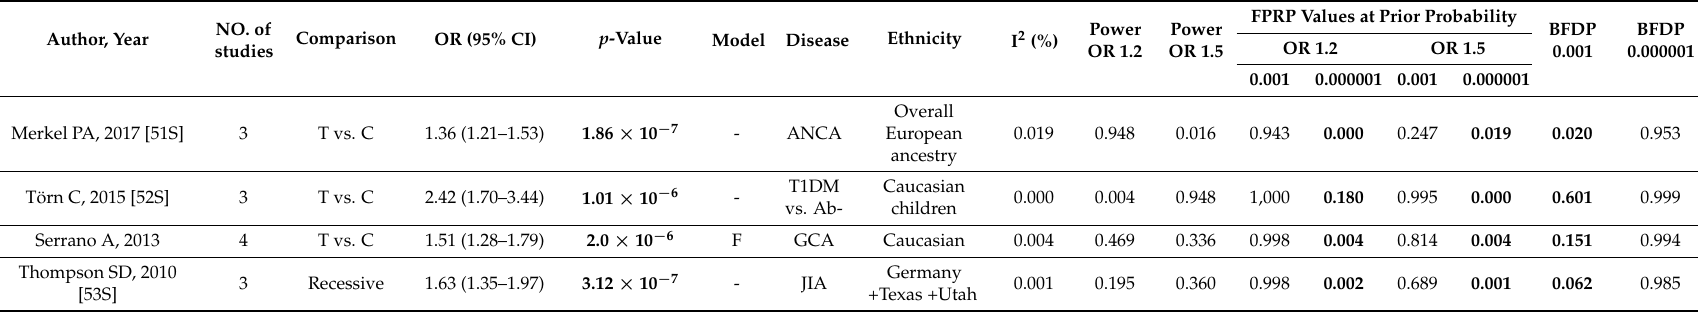
Table 9. Meta-analysis results of the PTPN22 1858 C/T polymorphism from genome wide association studies showing significant p -value (5 × 10 − 8 < p <